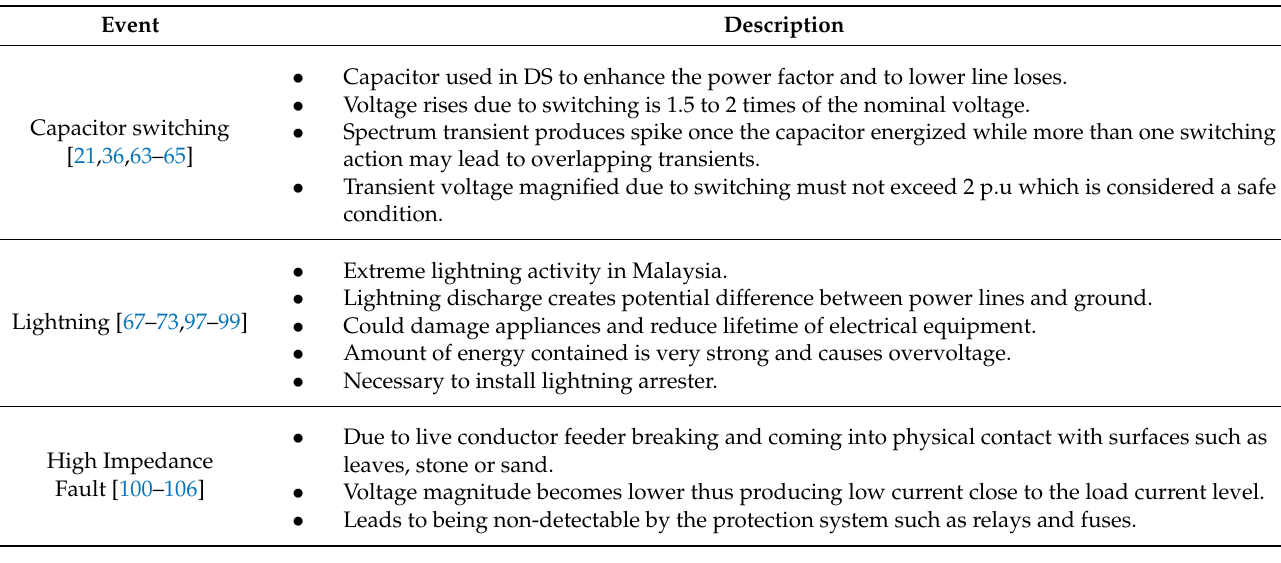
Table 4. Description of transient causes in distribution systems.